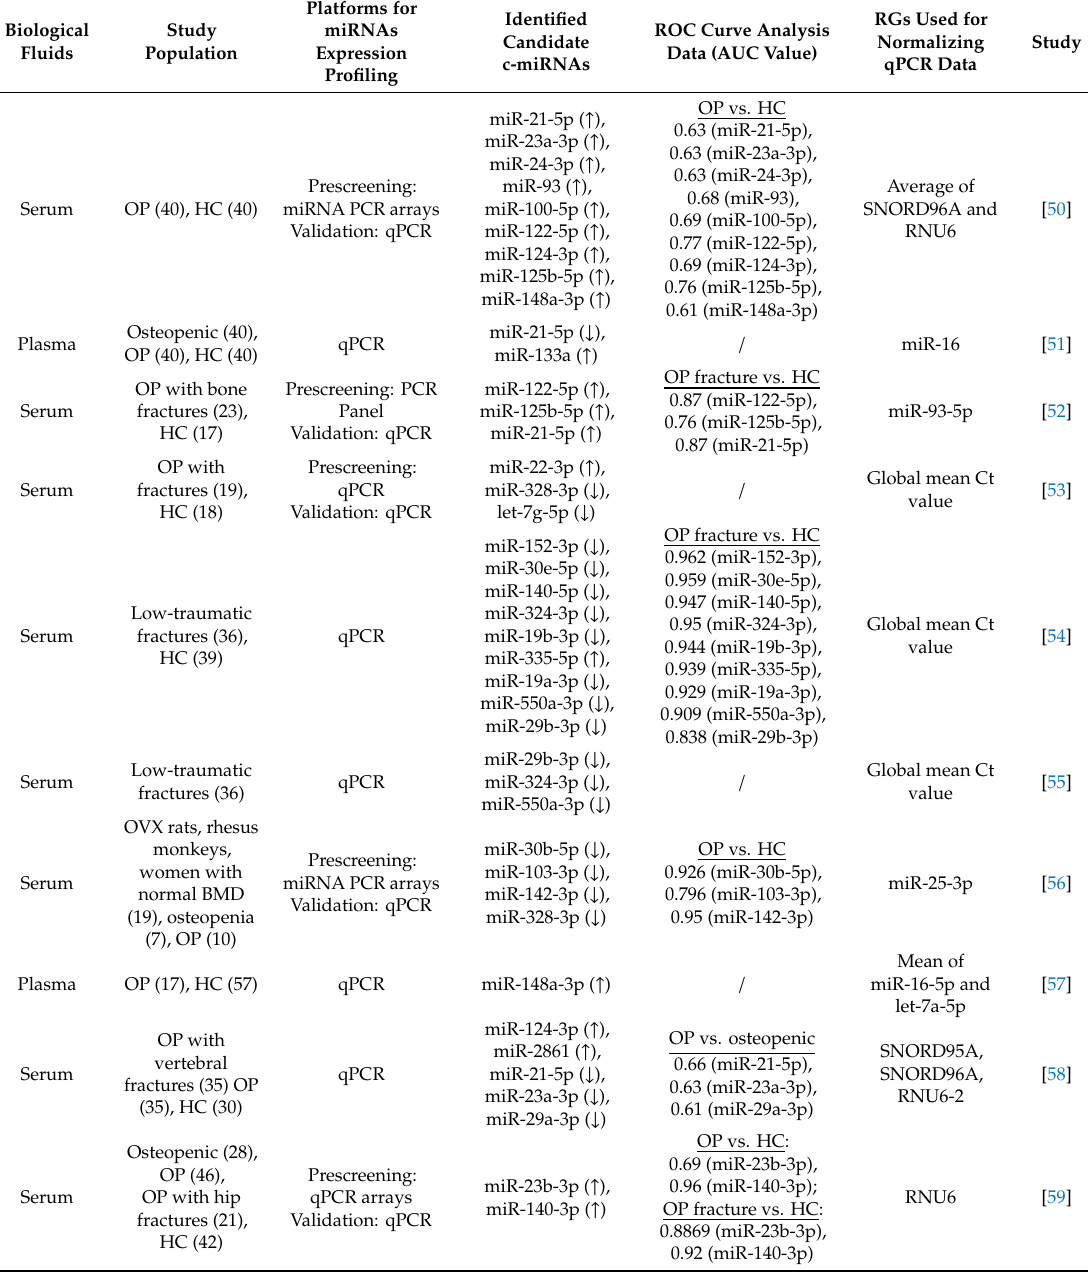
Table 1. Overview of c-miRNAs as candidate biomarkers in bone